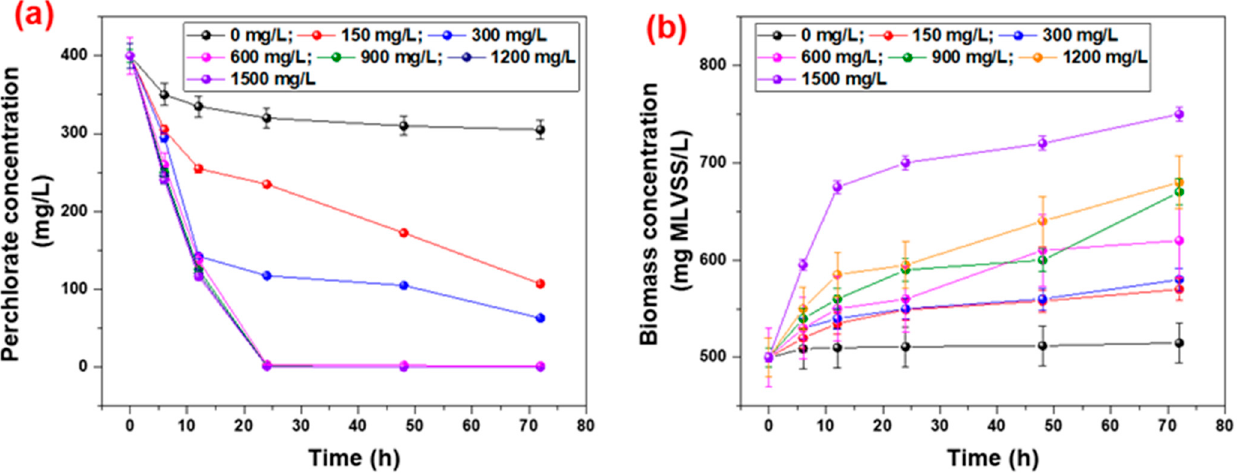
Figure 3. Impact of acetate concentration on perchlorate reduction by a mixed microbial culture and biomass concentration ( a ): perchlorate reduction (mg/L); ( b ): biomass concentration (mg MLVSS/L) (error bar represents the SD with a reading of 3 with maximum SD:5%).